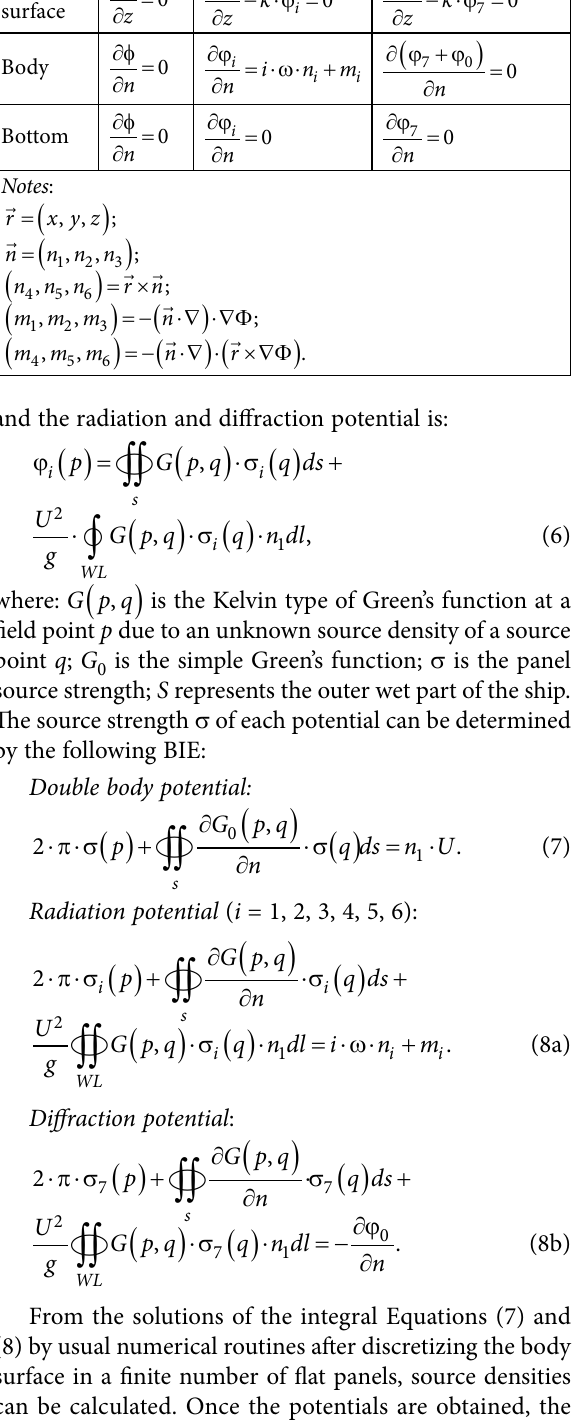
Table 2. BVPs of the potential flows 2 n